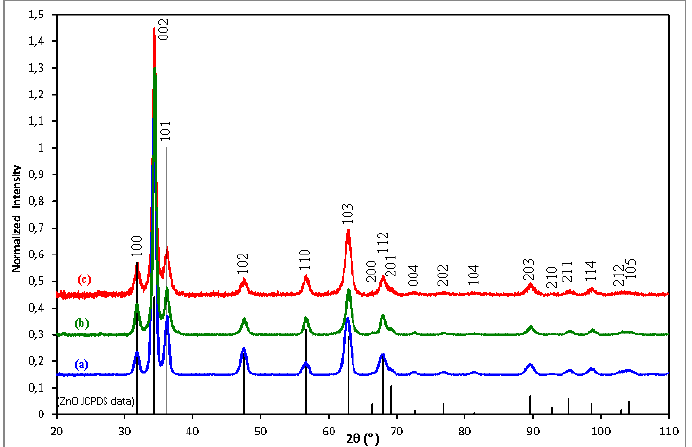
Figure 1. X-Ray Diffraction (XRD) patterns of 7-layer zinc oxide (ZnO) thin films obtained with an incident angle of 1°: ( a ) undoped, ( b ) 1 at.% Al-doped, ( c ) 2 at.%